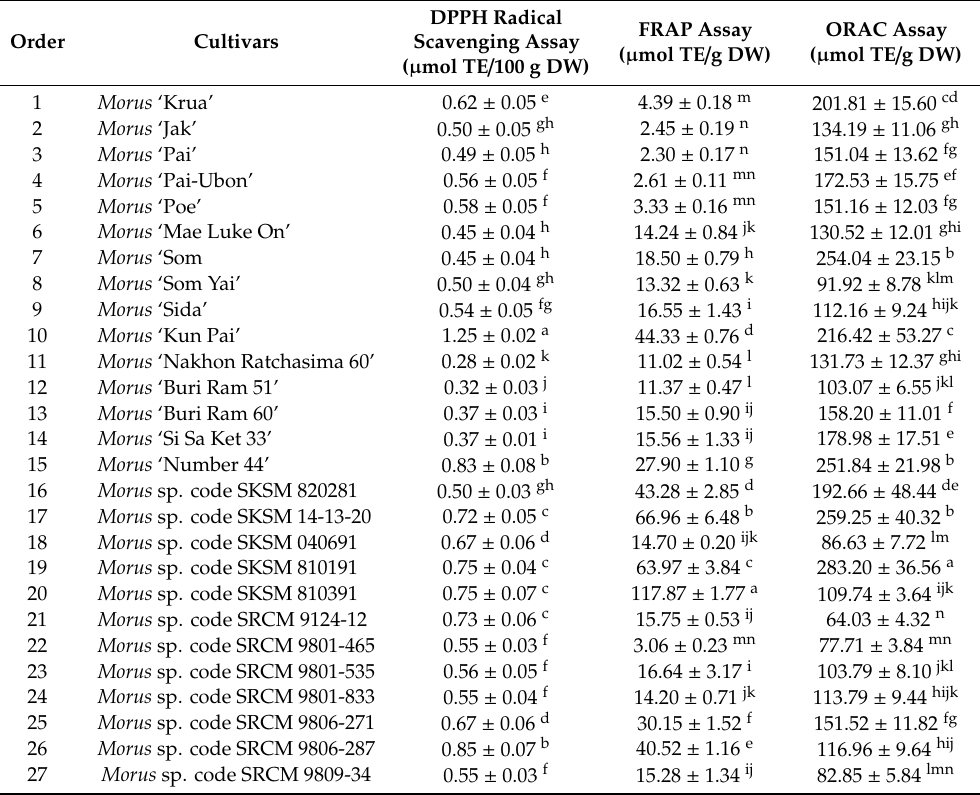
Table 2. Antioxidant analysis of aqueous extracts of Morus fruit